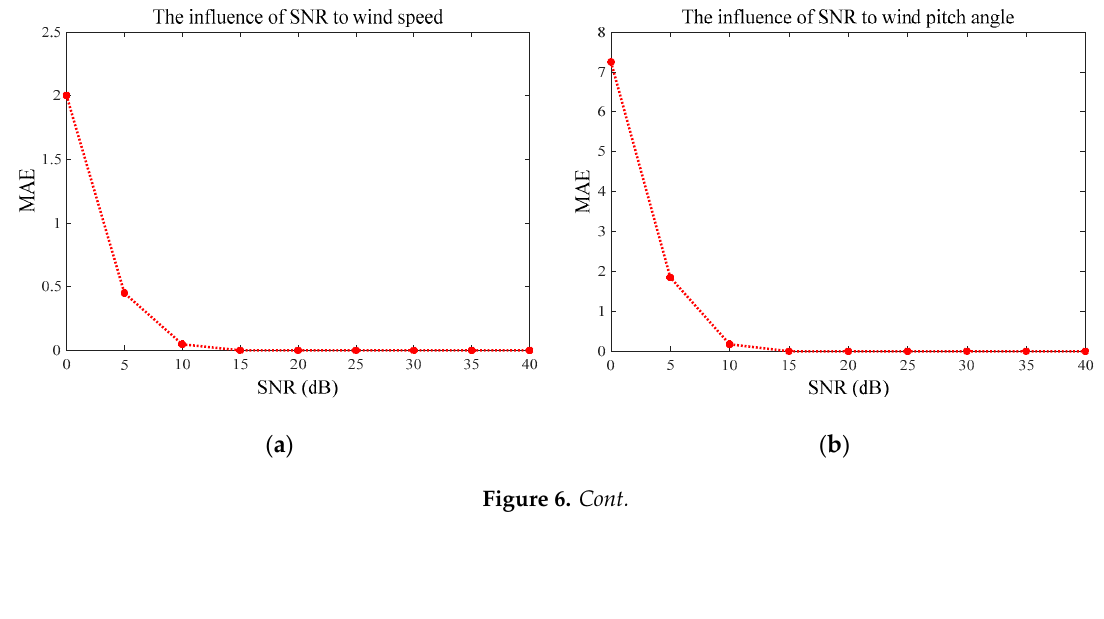
Figure 5. Results of Root Mean Square Error (RMSE) under different SNRs: ( a ) RMSE of the wind speed, ( b ) RMSE of the wind pitch angle, and ( c ) RMSE of the wind azimuth angle.